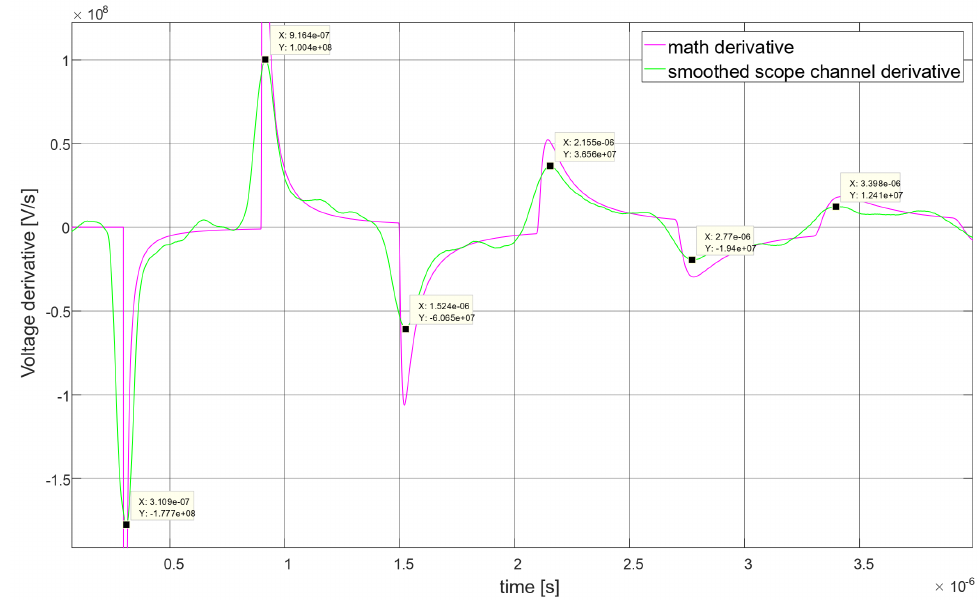
Figure 33. Comparison between the theoretical derivative and smoothed scope channel derivative.